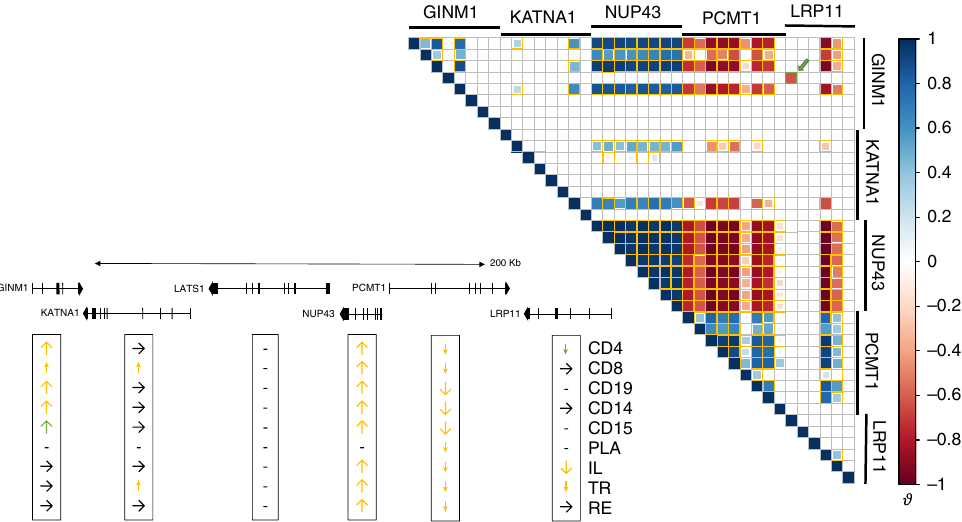
Fig. 3 Example of a multi-gene, multi-tissue cRM. Gene-tissue combinations for which no expression could be detected are marked by “ - ” , with detectable expression but without evidence for cis -eQTL as “ → ” , with detectable expression and evidence for a cis -eQTL as “ ↑ ” or “ ↓ ” (large arrows: FDR < 0.05; small arrows: FDR ≥ 0.05 but high | ϑ | values). eQTL labeled by the yellow arrows constitute the multi-genic and multi-tissular cRM no. 57. The corresponding regulatory variant(s) increase expression of the GINM1 , NUP43 and probably KATNA1 genes (left side of the cRM), while decreasing expression of the PCMT1 and LRP11 genes (right side of the cRM). The expression of GINM1 in CD15 and LRP11 in CD4 appears to be regulated in opposite directions by a distinct cRM (no. 3694, green). The LATS1 gene, in the same region, is not affected by the same regulatory variants in the studied tissues. Inset 1: ϑ values for all EAP pairs. EAP pairs with | ϑ | > 0.6 are bordered in yellow when corresponding to cRM no. 57, in green when corresponding to cRM no.